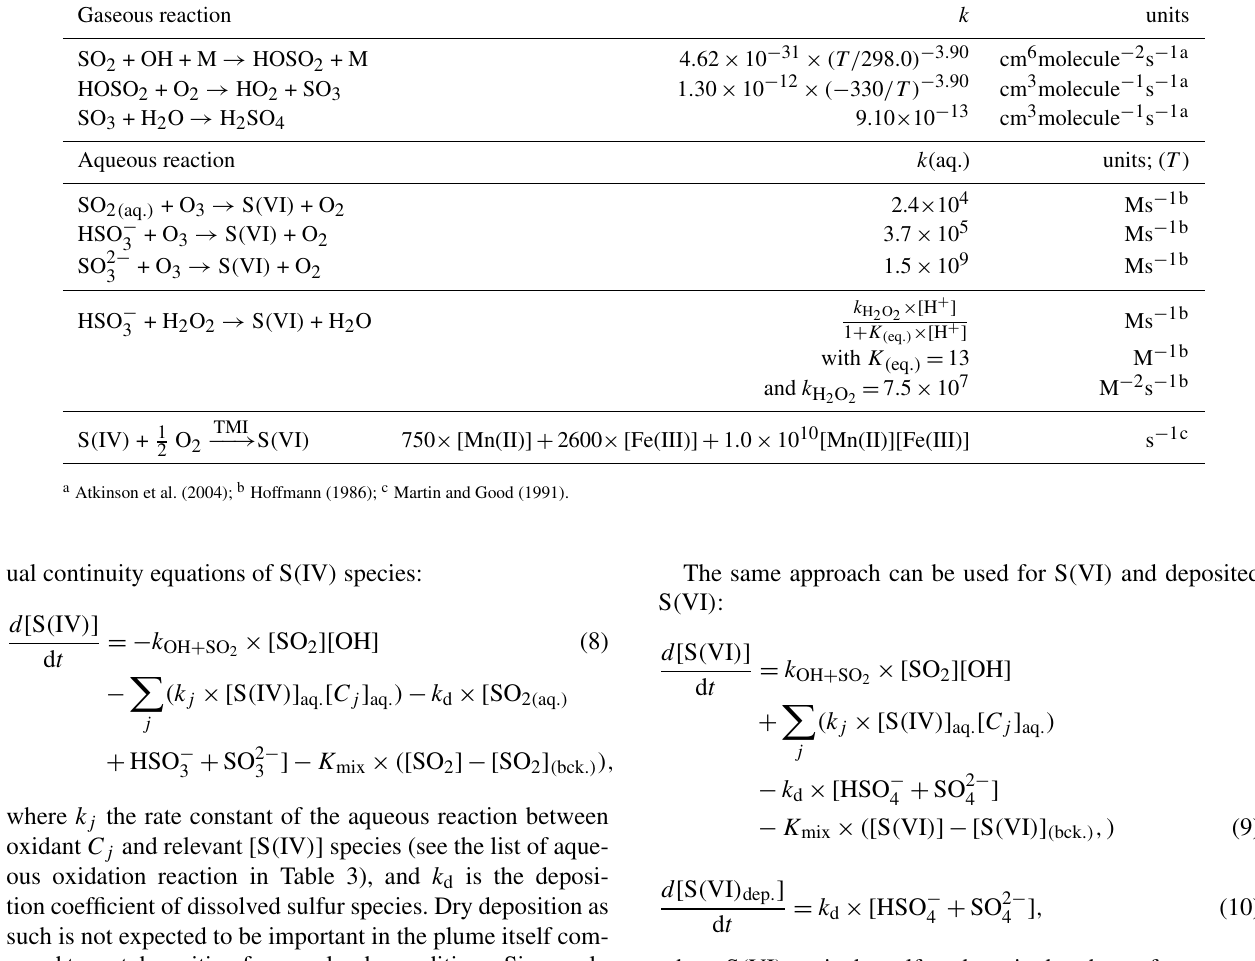
Table 3. Sulfur chemistry scheme. Gaseous